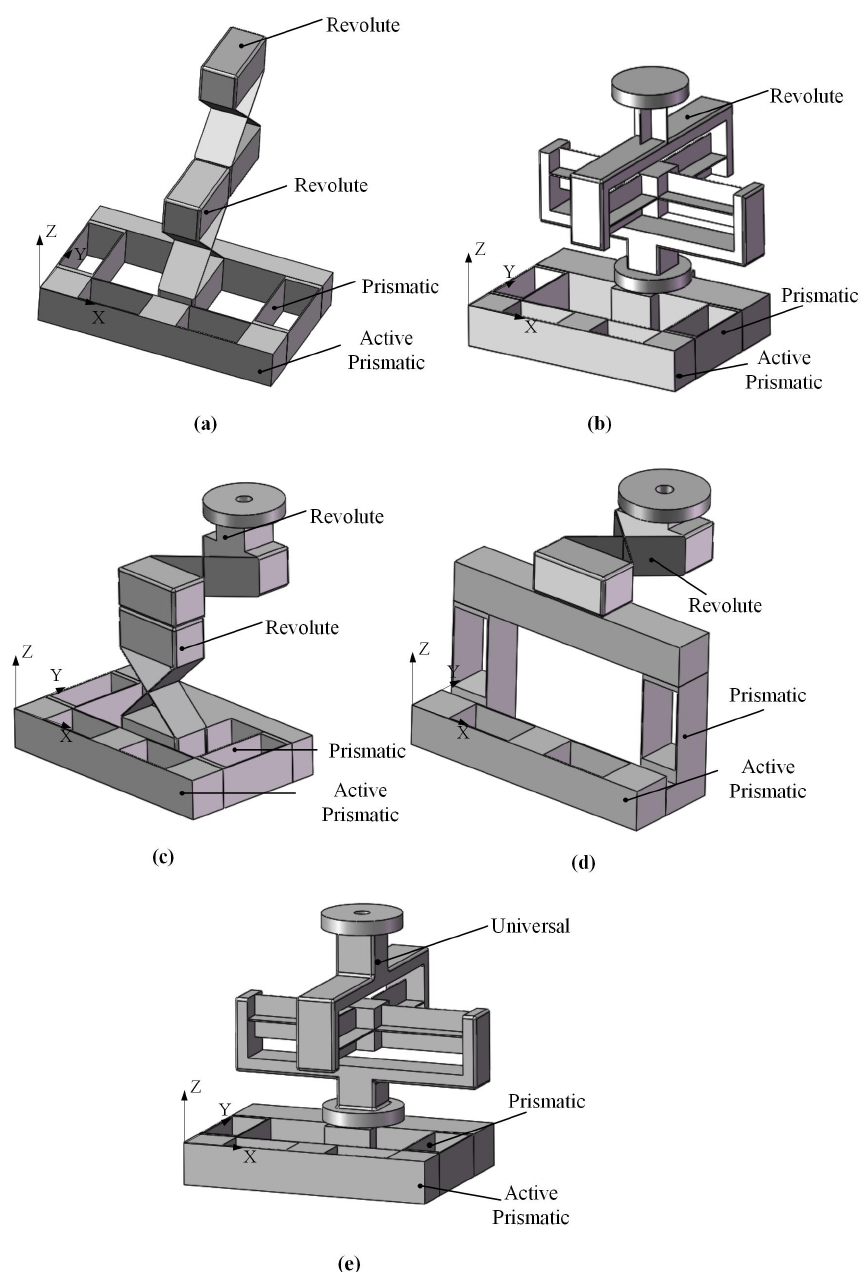
Figure 5. (a) P j P i ( RR ) i compliant branch. (b) P j P i S compliant branch. (c) P j P i R j R k compliant branch. (d) P j P i R k compliant branch. (e) P i P j U ij compliant